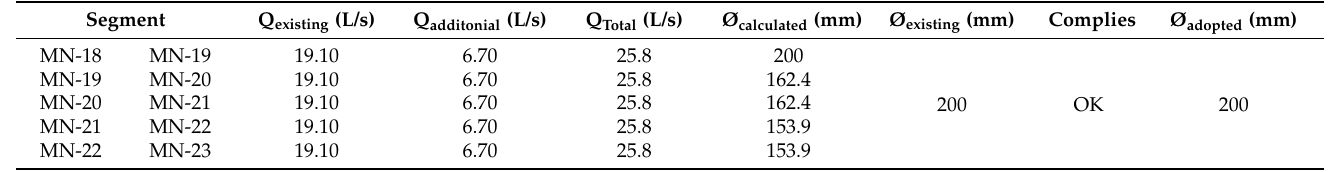
Table 13. Capacity of the pipeline connecting to the sewerage network of EA2-3.